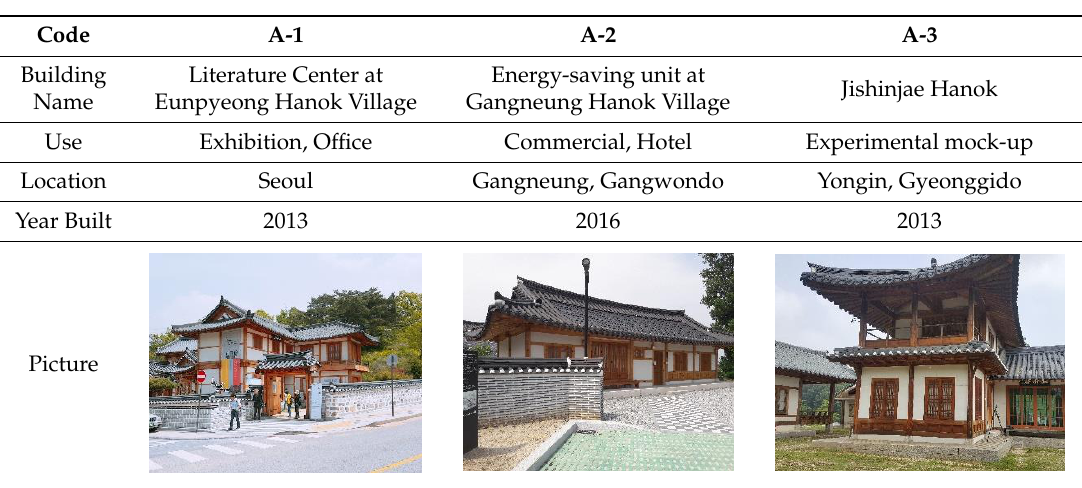
Table 2. Public Hanok facilities in Type A.